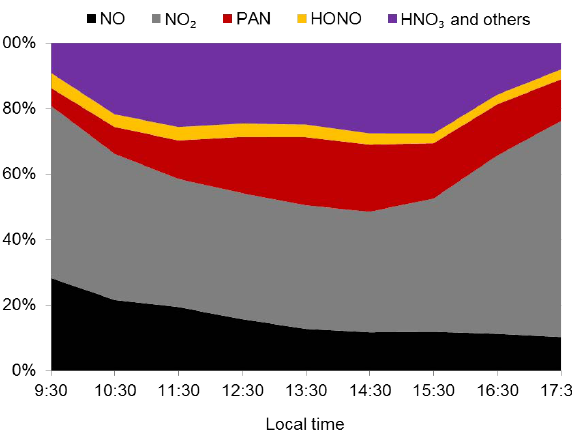
Fig. 6. Daytime evolution of NO y